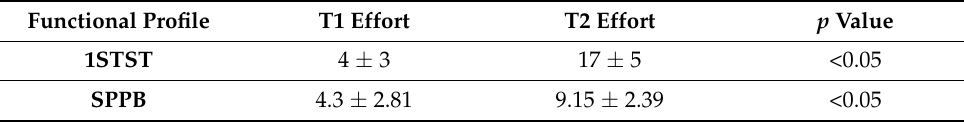
Table 3. Functional and rehabilitative profile during hospitalization. Functional